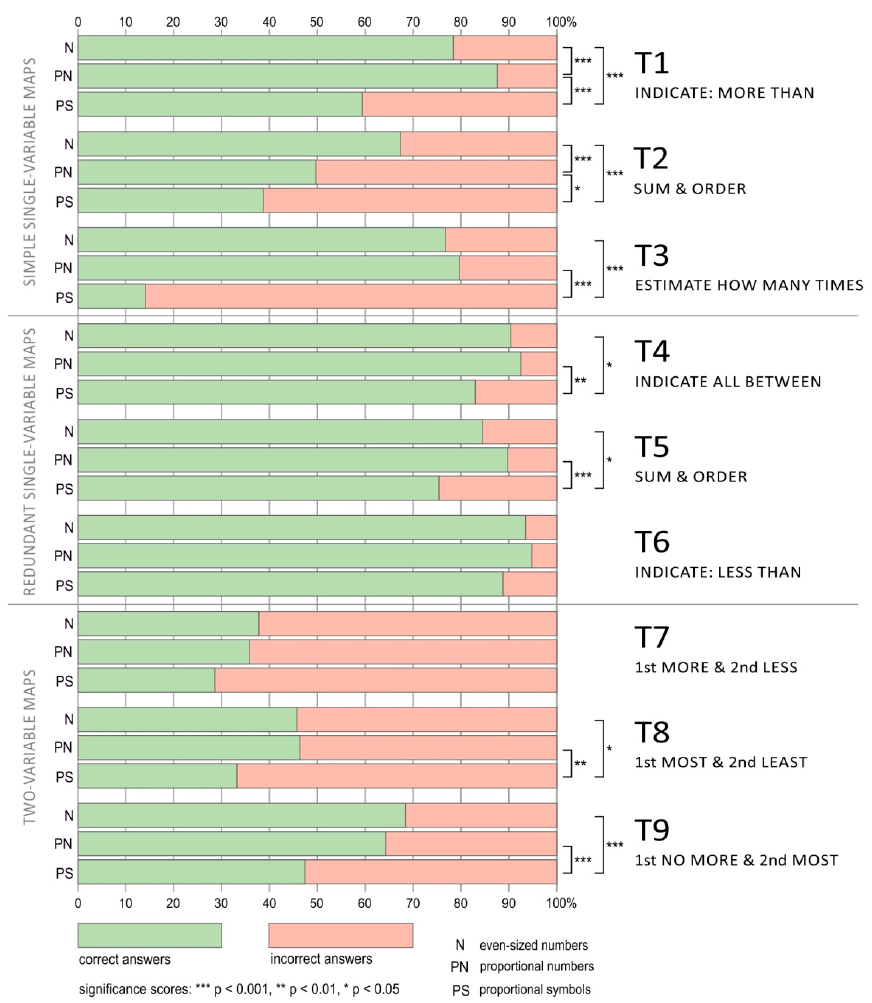
Figure 5. The proportion of correct answers, taking into account the data presentation methods used on maps in tasks T1–T9.